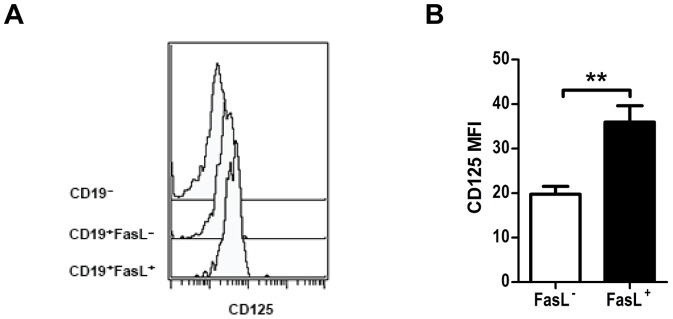
FasL+ B cells express higher levels of the IL-5 receptor than FasL
−
B cells. (A) Histograms comparing surface expression of CD125 in CD19−, CD19+FasL− and CD19+FasL+ cells. (B) Quantification of median fluorescence intensity of CD125 expression in CD19+FasL− and CD19+FasL+ B cells in replicate animals (mean ± SEM). **p<0.01.